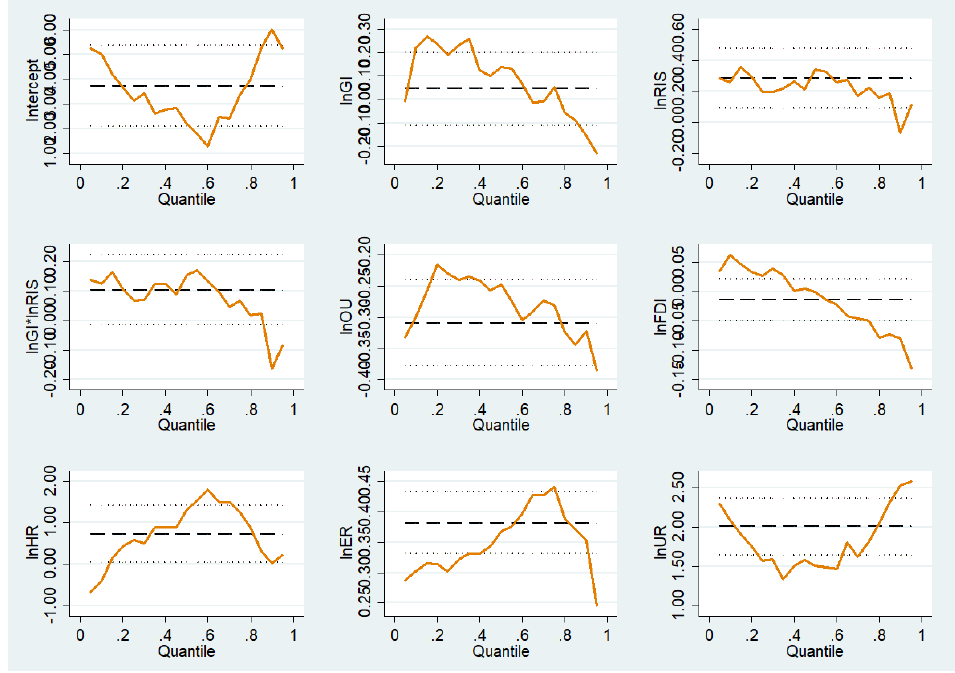
Figure 1. Variation of quantile regression coefficients for each factor. Table 10. Panel quantile regression results for the upgrading of the industrial structure.